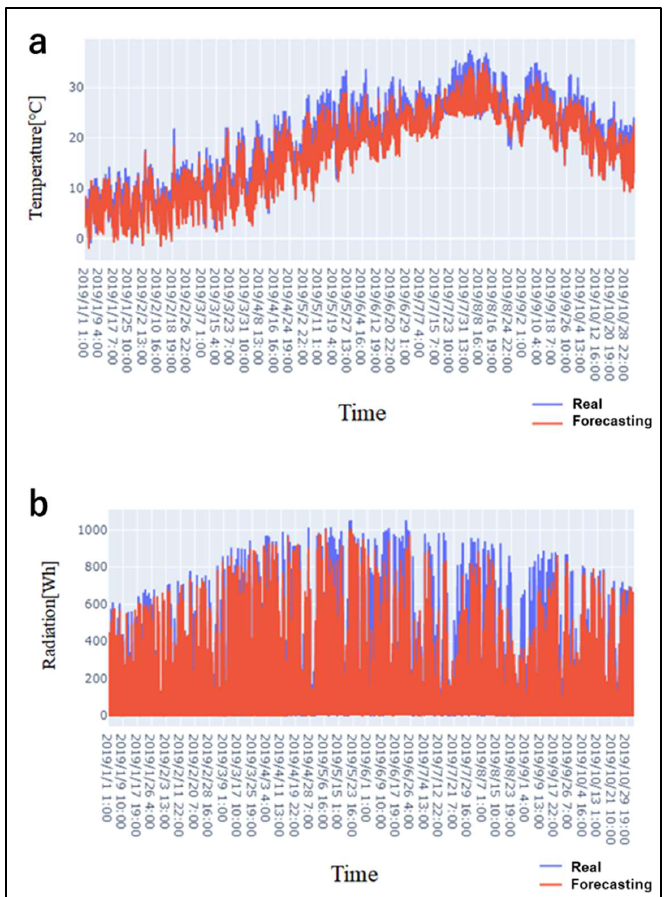
Figure 14. Comparison between the real and forecasting meteorological data used in this study: ( a ) Temperature; ( b ) Solar radaition.